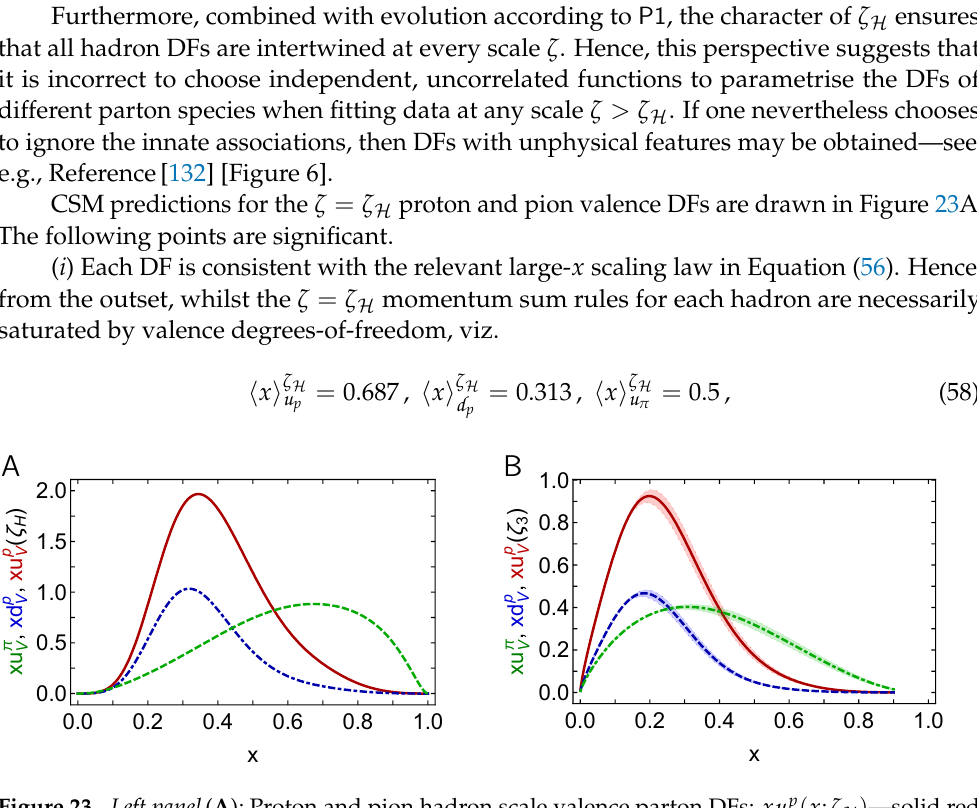
Figure 23. Left panel ( A ); Proton and pion hadron scale valence parton DFs: x u p ( x ; ζ H ) —solid red curve; x d p ( x ; ζ H ) —dotted-dashed blue curve; x u π ( x ; ζ H ) —dashed green curve. Right panel ( B ): Valence DFs in Panel A evolved to ζ 3 = m J / ψ = 3.097GeV according to P1 . The band surrounding each CSM curve expresses the response to a ± 5% variation in ζ H